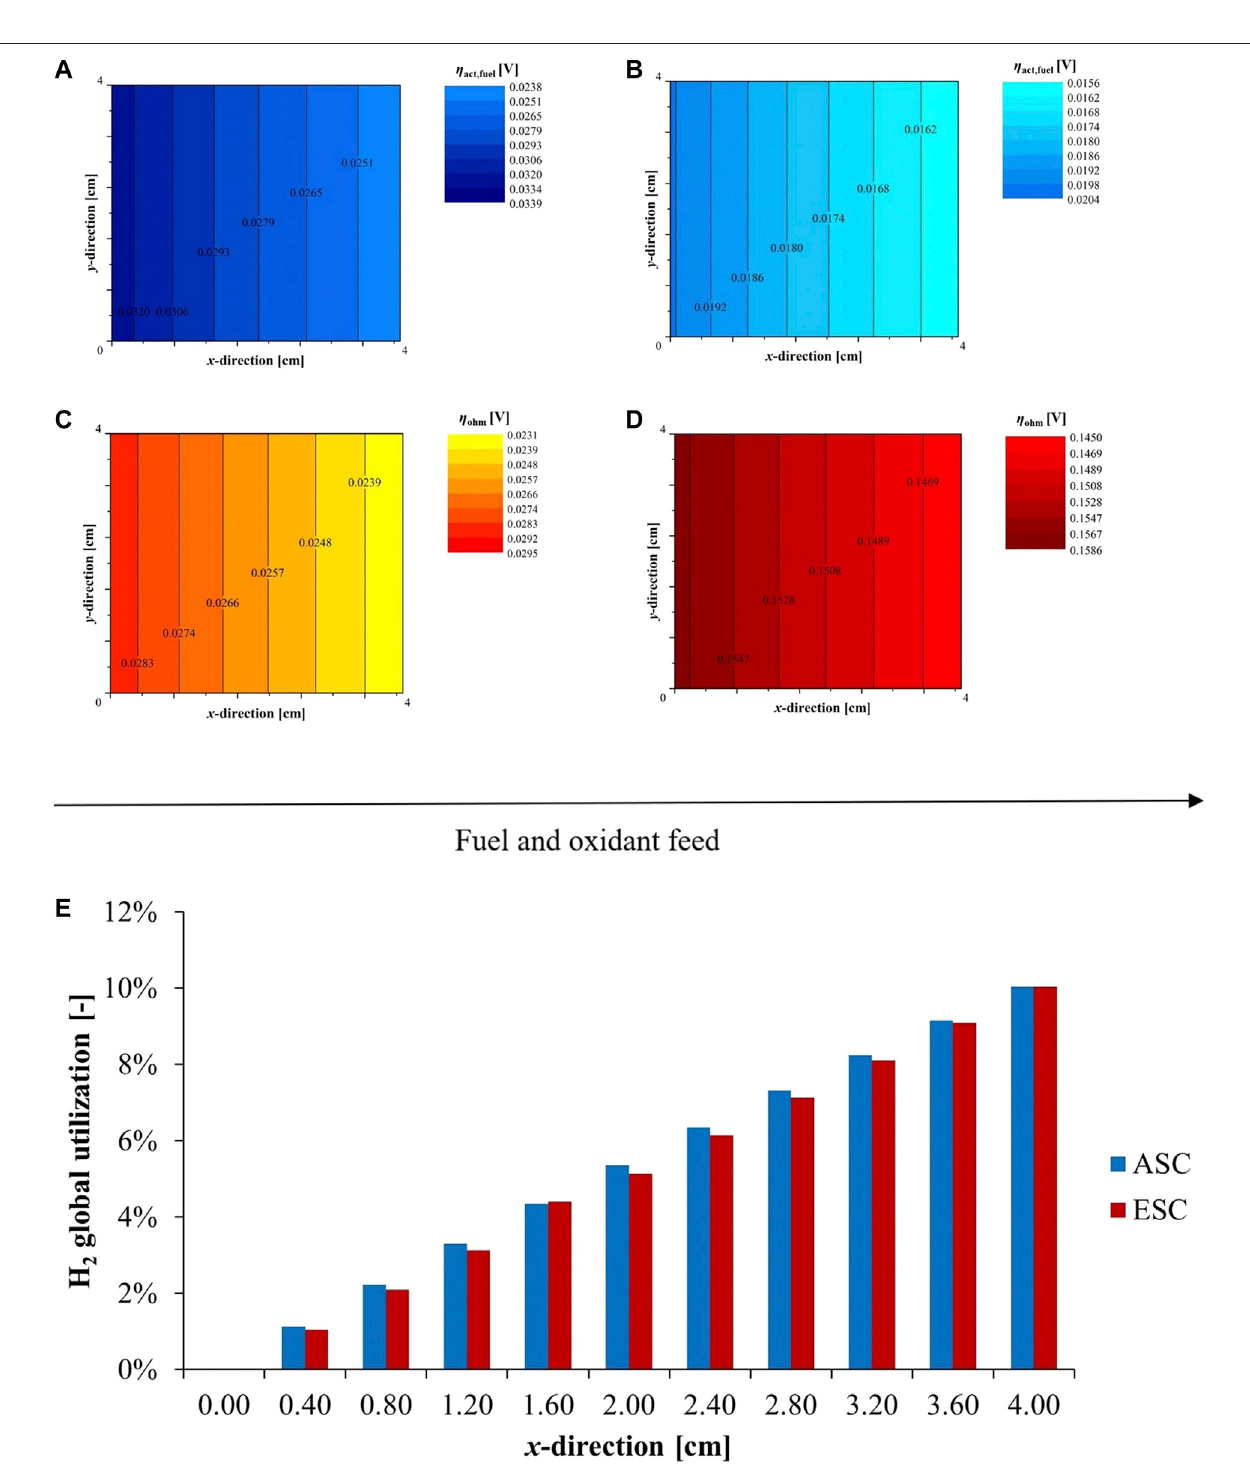
FIGURE 10 | Local cell performance feeding 80/20 H 2 /H 2 O mixture and dry air at 800 ° C - (A) ASC and (B) ESC activation overpotential at fuel electrode, (C) ASC and (D) ESC ohmic overpotential – and (E) H 2 cumulative conversion along fl ow direction according to SIMFC outcomes.